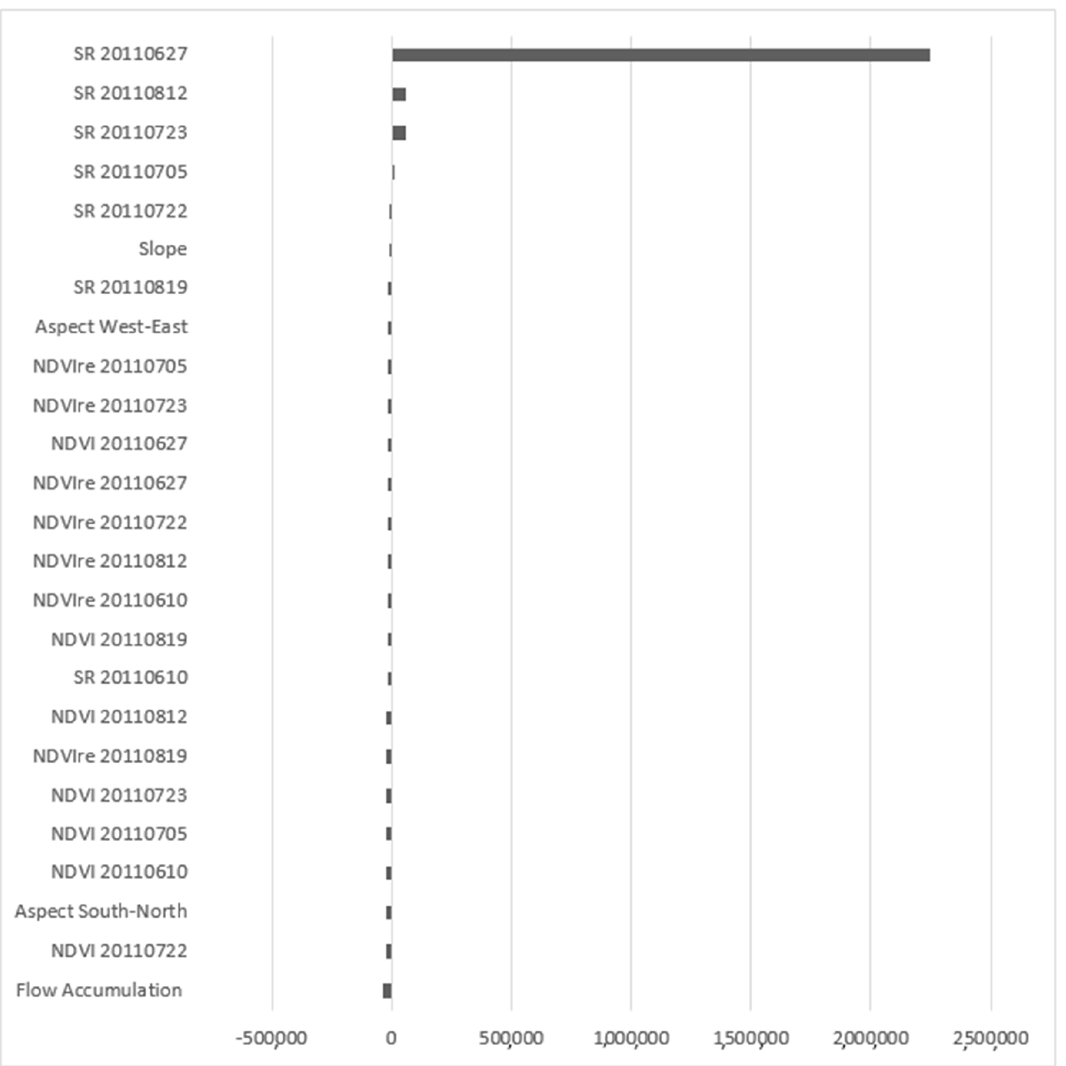
Figure A4. Importance of variables for the corn 2011 ANN model, as measured by Connection weights (larger positive or negative values indicate higher